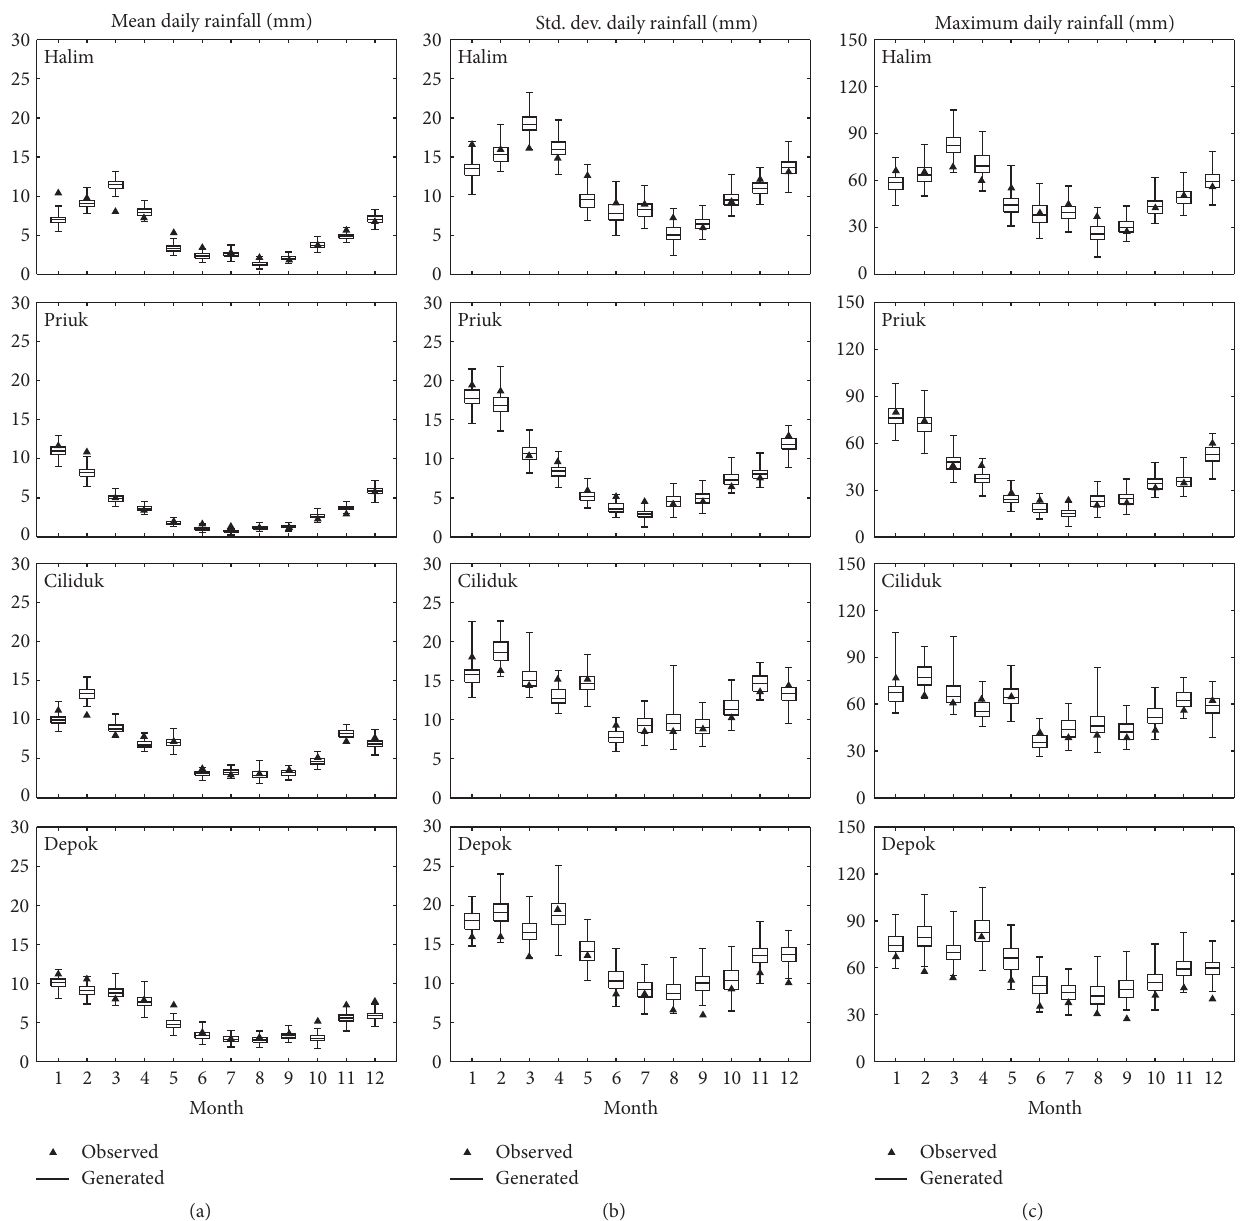
Figure 6: Comparison of observed mean (a), standard deviation (b), and maximum daily rainfall (c) with SDSM generated rainfall sequences at the four stations. The observed data are for the period of 1984–2006. The boxplots are obtained from 100 realizations of 23-year-long SDSM generated data. Whiskers indicate minimum and maximum out of 100